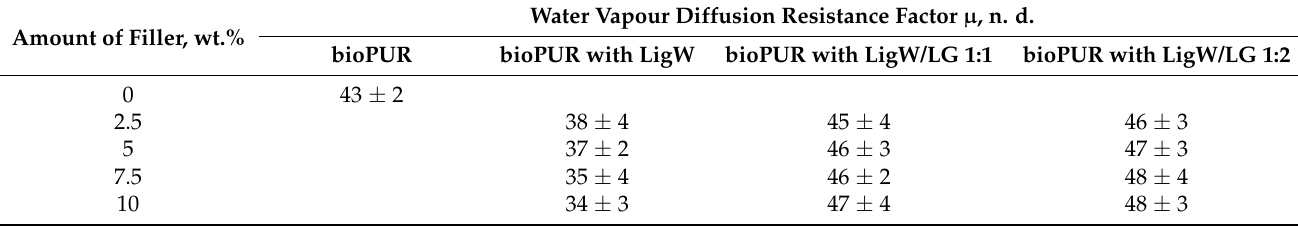
Table 5. Water vapour permeability of bioPUR